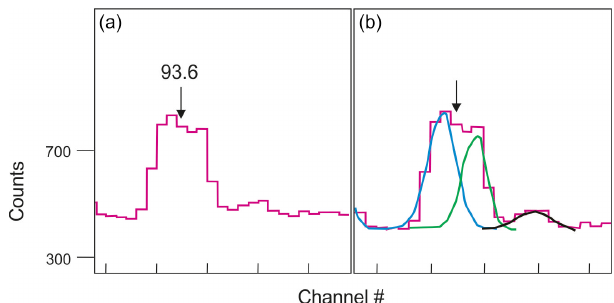
Figure 4. Fitting the 92–93keV energy peak using the g3 software (see Appendix D for details). (a) Typical 93keV peak; (b) decon- volution of peak resulting in three different peak functions (blue, green, black). Figure adapted from Abdualhadi (2016).